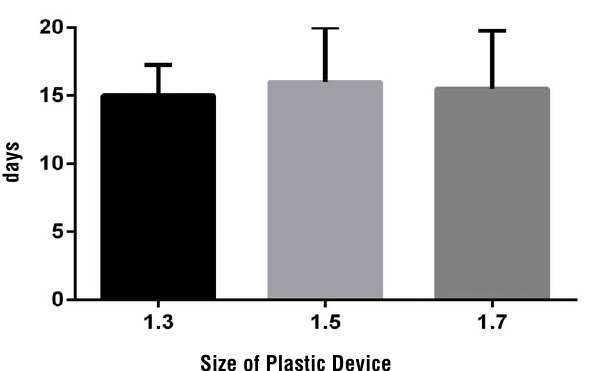
Figure 2 - Comparison between time to fall off and size of the plastic device. Data are shown as medians and maximum time.